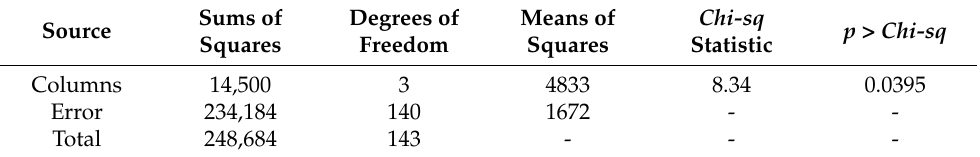
Table 10. Results of Kruskal–Wallis test for oil Midel 1204 with different concentrations of surfactant oleic acid.